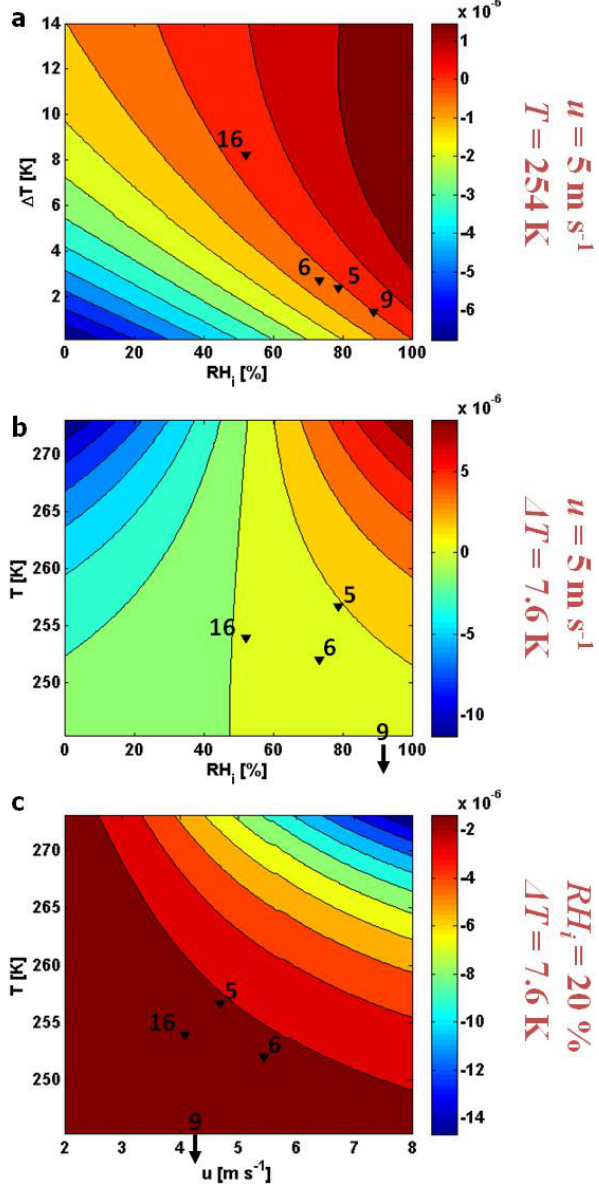
Fig. 7. SU s rates (kgm − 2 s − 1 ) from 3 sensitivity experiments, with (a) wind speed u = 5ms − 1 and air temperature T = 254K, (b) u = 5ms − 1 and surface temperature inversion 1T = 7 . 6K, and (c) relative humidity with respect to ice RH i = 20% and 1T = 7 . 6K. Mean values for RH i , u and 1T s were calculated for AWS 5, 6, 9 and 16 for snowdrift-free conditions and used to plot each